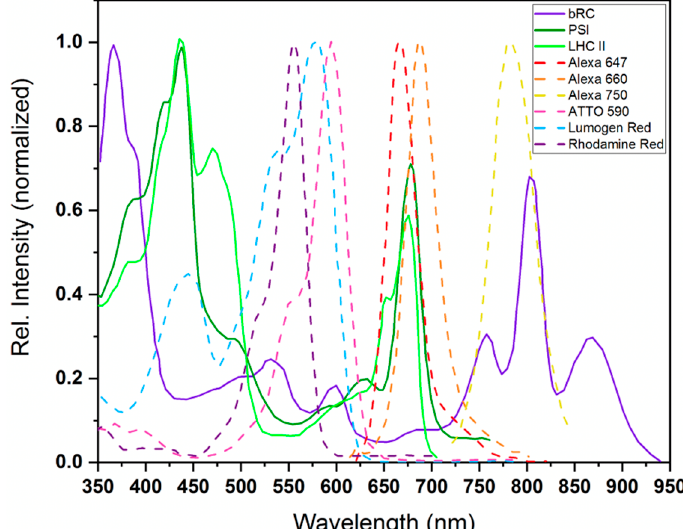
Figure 3. Optical cross sections of reaction centers and dyes. The UV–Visible absorption spectra of commonly studied biological reaction centers and dyes used to extend their optical cross sections are shown. The maxima of each spectra were normalized to 1.0 for comparison.